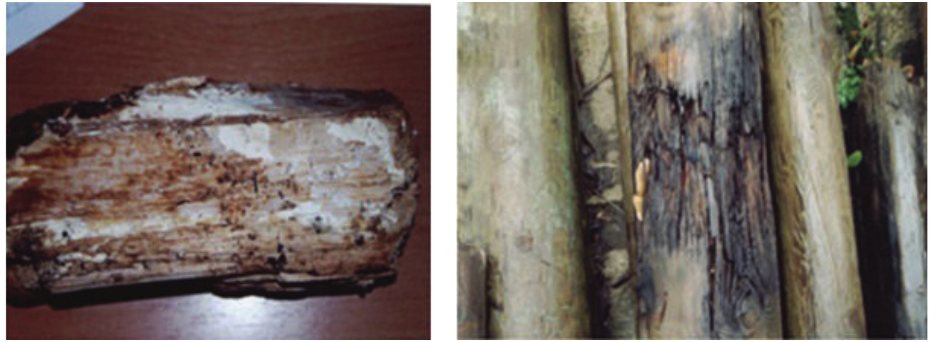
Figure 3: White- and brown-rot fungi observed on utility poles in Artvin